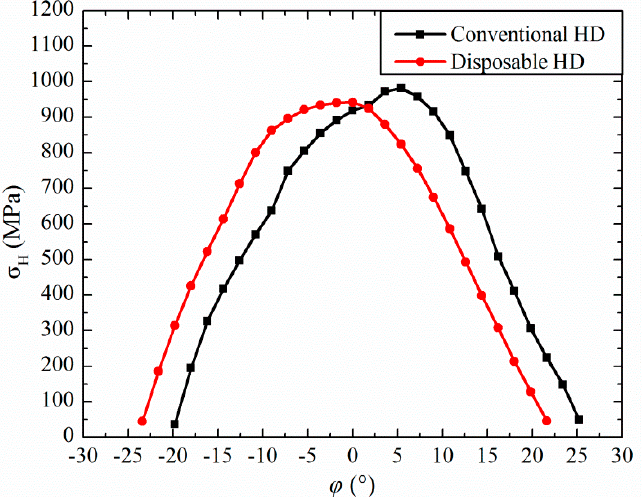
Figure 13. Harmonic transmission contact stress of involute tooth profile.